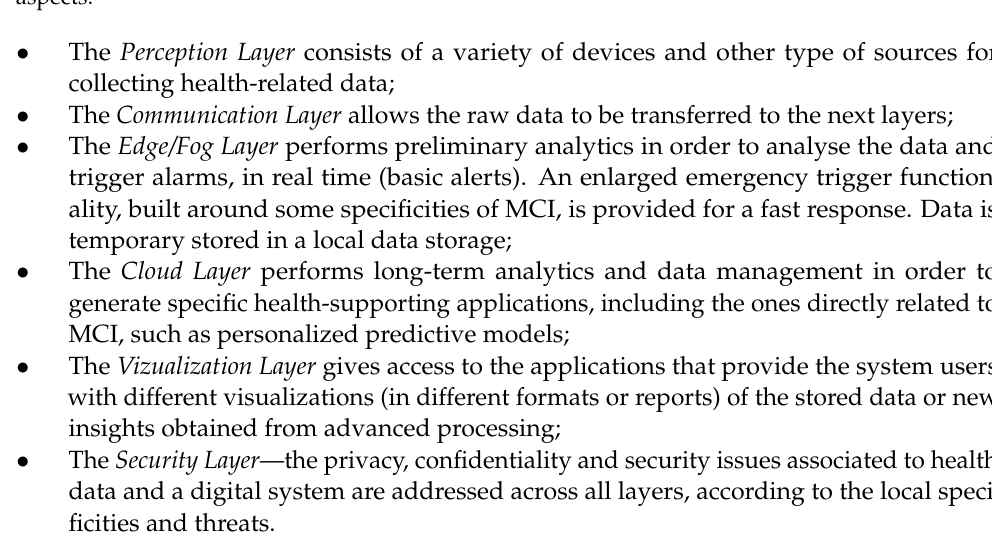
Figure 2. The functional architecture of the RO-SmartAgeing system with highlighted MCI-related